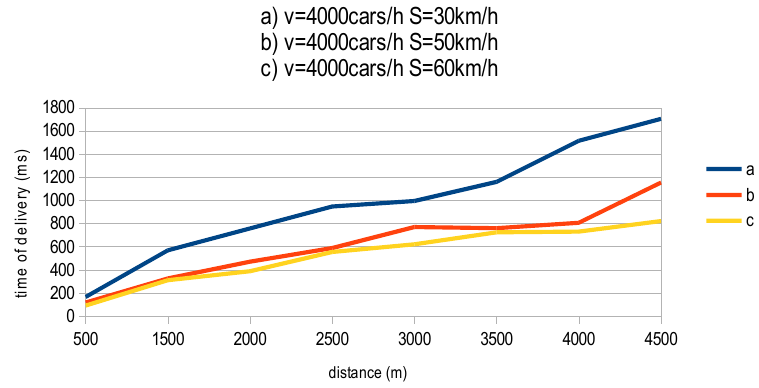
Figure 8. Packet delivery time for with the distance between RSU stations for scenario (C).